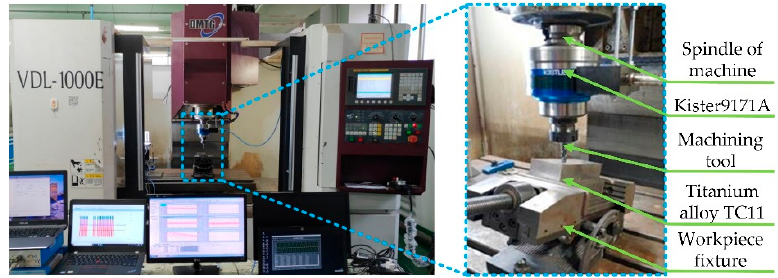
( b ) Figure 10. Profile accuracy detection of a revolving cycloid milling cutter: ( a ) Test equipment; ( b ) test results. The red line in the figure presents the theoretical contour, while the blue line presents the limit deviation range of grinding precision. According to testing results of grinding precision, the edge diameter, the height of the end tooth, and the grinding precision of cycloid cutting edge can satisfy the precision requirements of the limit deviation range. Margins within the limit deviation range can be found at large curvatures on both sides of the contour, while overcut within the limit deviation range can be found at small curvatures. It is mainly caused by the grinding and feeding speed that failed to adjust according to the change of the removal rate of materials. The grinding and feeding speed will be optimized to enhance the grinding precision in a local area of the tool. 4. Study on the Cutting Performance of the Revolving Cycloid Milling Cutter 4.1. Test Conditions